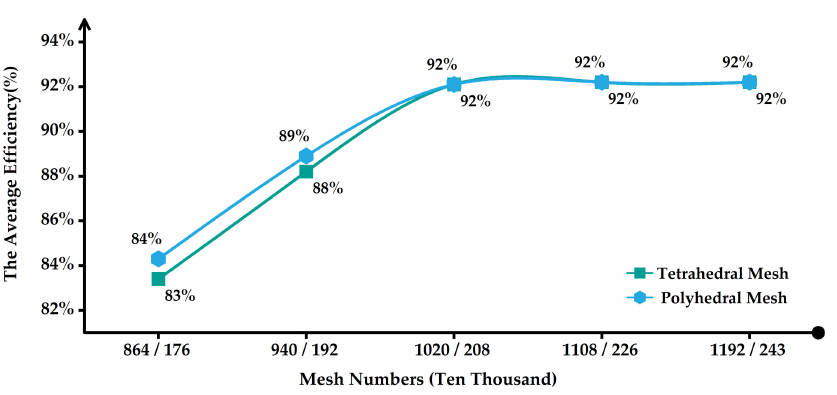
Figure 2. Variation curves of numerical calculation efficiency of different mesh schemes.